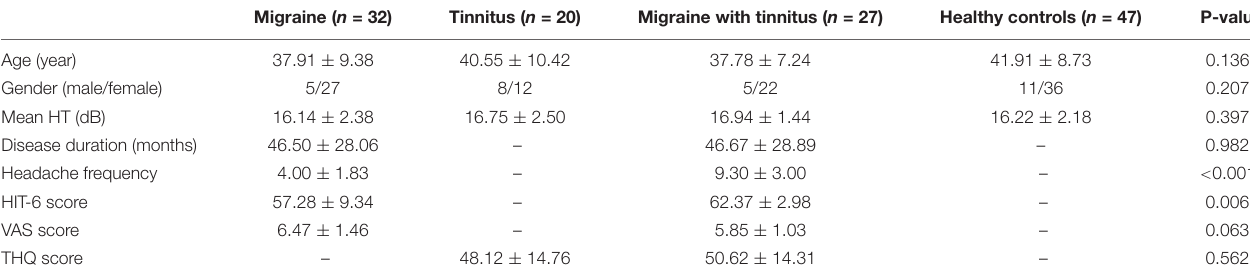
TABLE 1 | Demographics and clinical